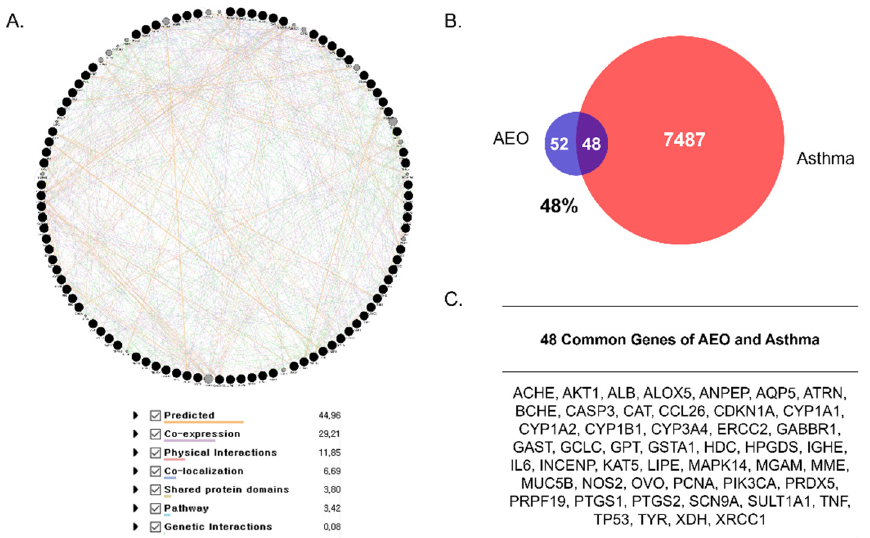
Figure 1. Network pharmacological analysis of AEO. ( A ) Network of AEO with 106 nodes and 968 edges. The nodes and edges indicate the targeted genes of AEO and their relationships, respec- tively. The black nodes present seed nodes and the gray ones are nodes that interact with the seed nodes. Yellow, predicted; purple, co-expression; pink, physical interactions; blue, co-localization; light green, shared protein domains; sky, pathways; green, genetic interactions. ( B ) Veen diagram of intersection targets between AEO network and the gene sets of asthma disease. ( C ) Common genes of AEO and